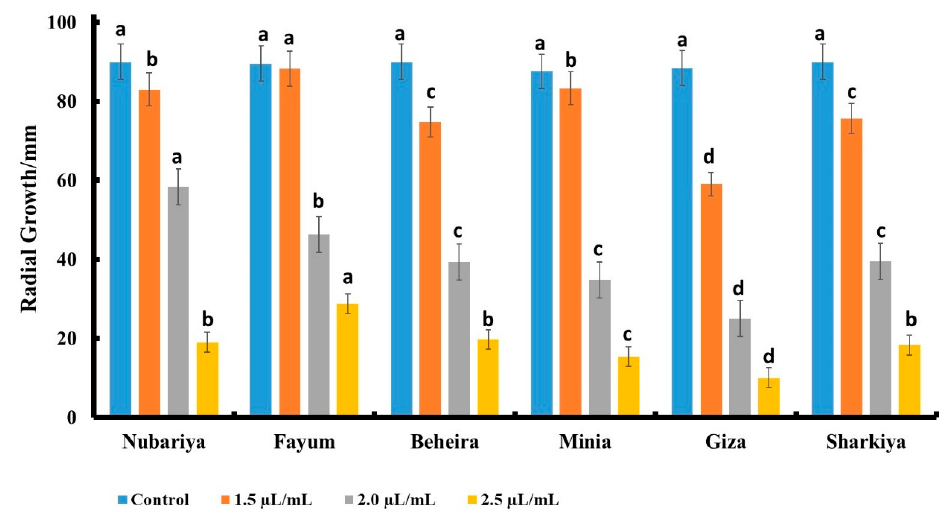
Figure 5. Effect of different concentrations of commercial Premis Ultra 2.5% fungicide on the growth of H. maydis isolates from different origin sites at 7 days post-inoculation. All values are presented as a mean of five replicates + SE. a,b,c,d Estimates with the same letters are not significantly different ( p < 0.05) among different isolate sources (governorates) for the same concentration .